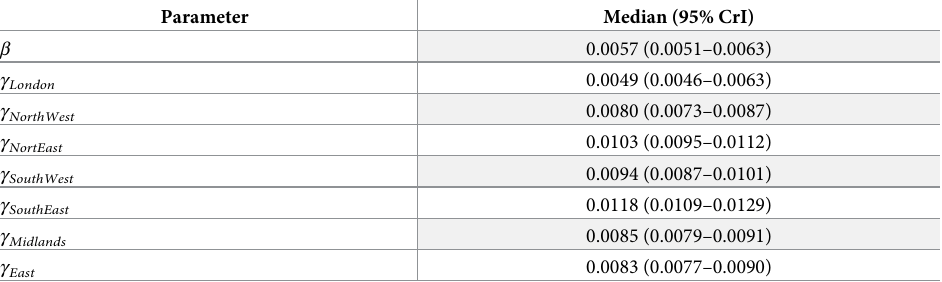
Table 1. Marginal median parameter estimates and 95% CrI for the constant IFR model. β is the rate of serorever- sion and γ denotes the IFR. The estimated median time to seroreversion given by 1/ β is 176 (95% CrI: 159–197